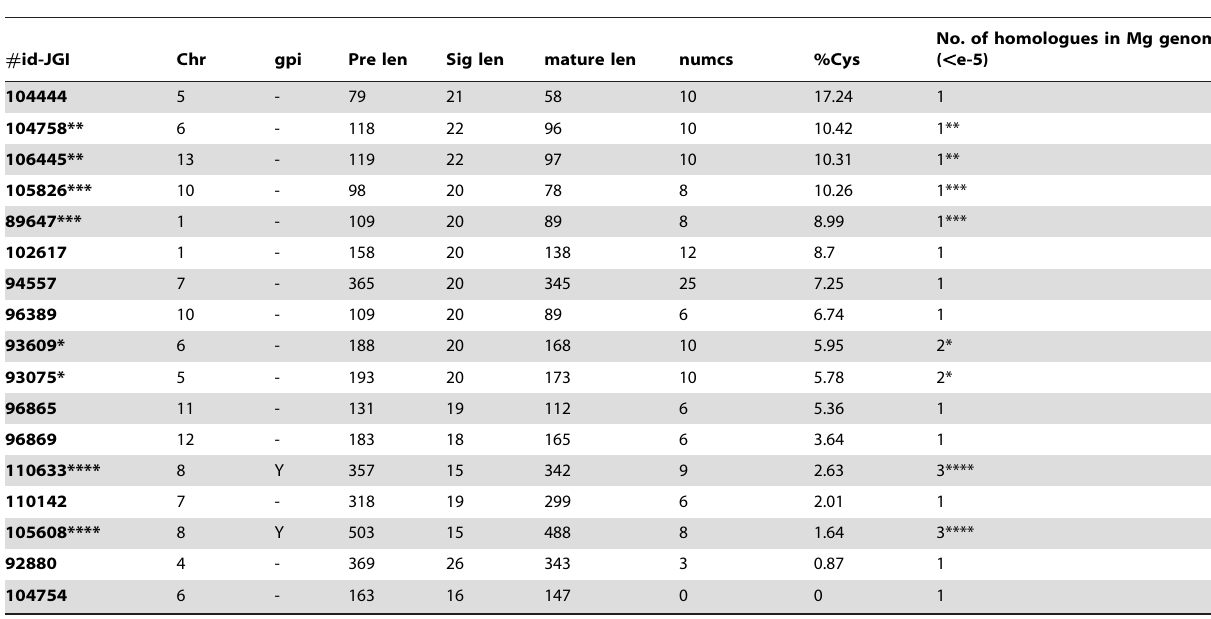
Table 9. Features of the predicted secreted proteins unique to M. graminicola based on interspecies BLASTP analysis (e-5).